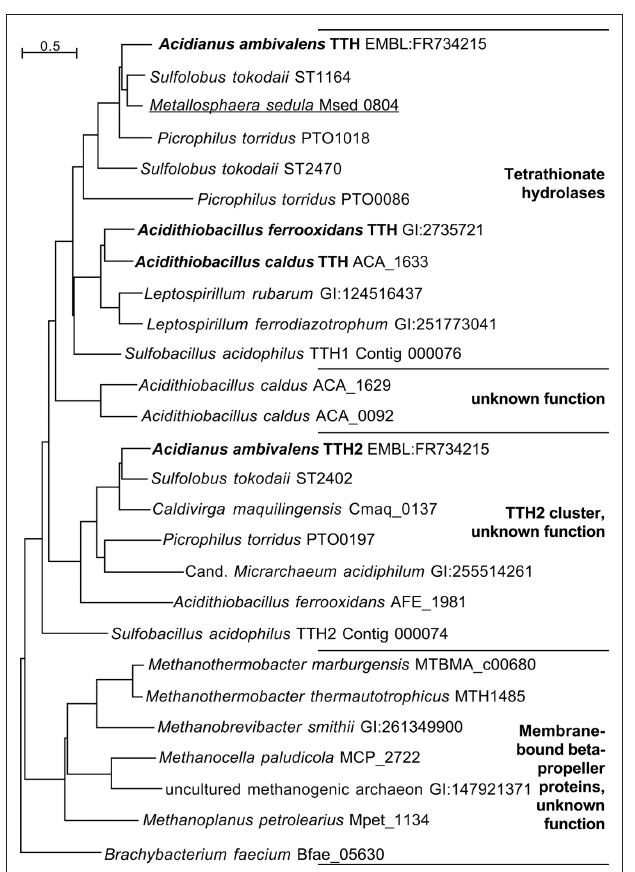
FiguRe 5 | Phylogenetic dendrogram of the TT hydrolases with 26 of the closest homologs from Archaea and Bacteria. Bold face, biochemically characterized TTH enzymes (Bugaytsova and Lindström, 2004; Kanao et al., 2007; Rzhepishevska et al., 2007); underlined, gene described in transcriptome study (Auernik and Kelly, 2008). The Sulfobacillus TTH homologs were identified in the draft genome sequence available at http://www.jgi.doe.gov (as of